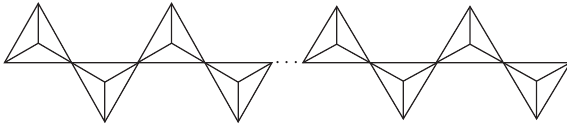
Figure 2: The chain silicate networks C